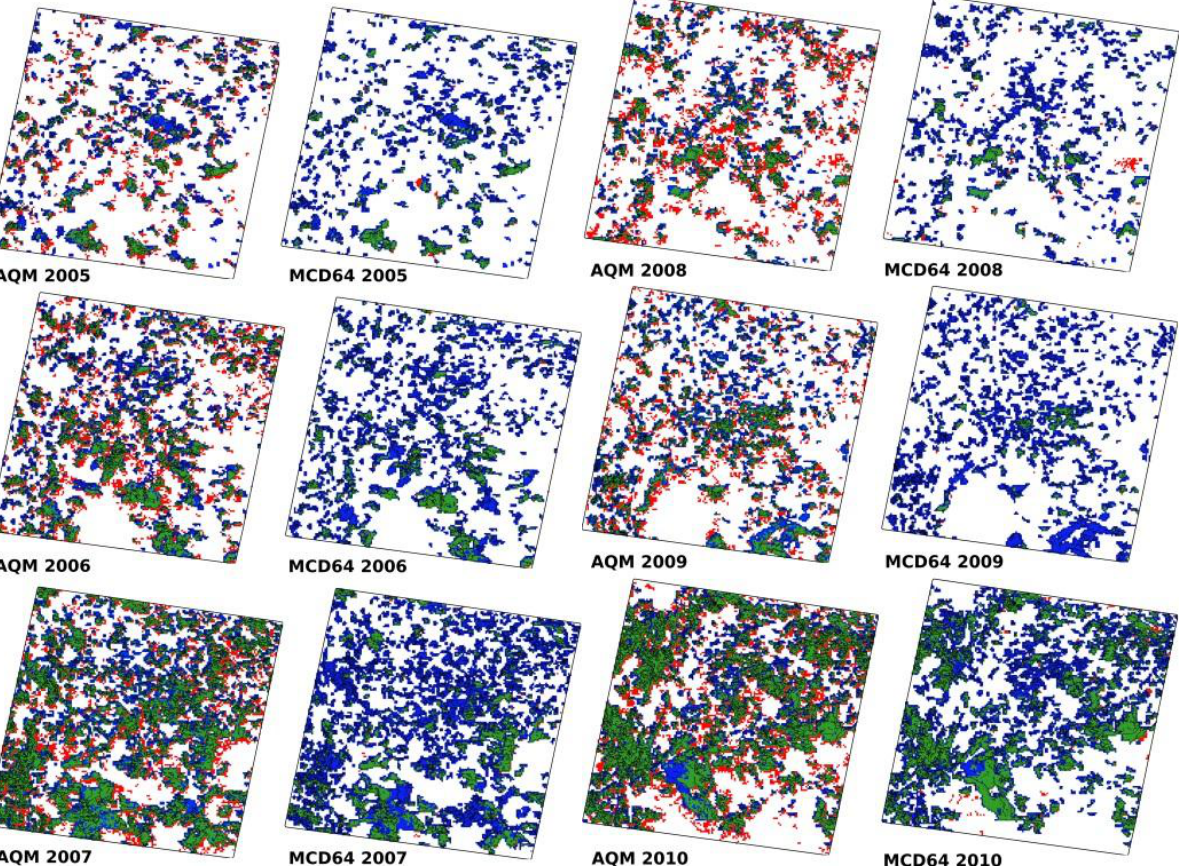
Figure 6. Maps showing pixels where truly burned areas were detected (green), together with omission (blue) and commission (red) errors. TM reference scars (black lines) are superimposed. Results are from AQM and MCD64A1 over Jalapão and for 2005 (JA), 2006 (JJAS), 2007 (JJA), 2008 (J), 2009 (JA) and 2010